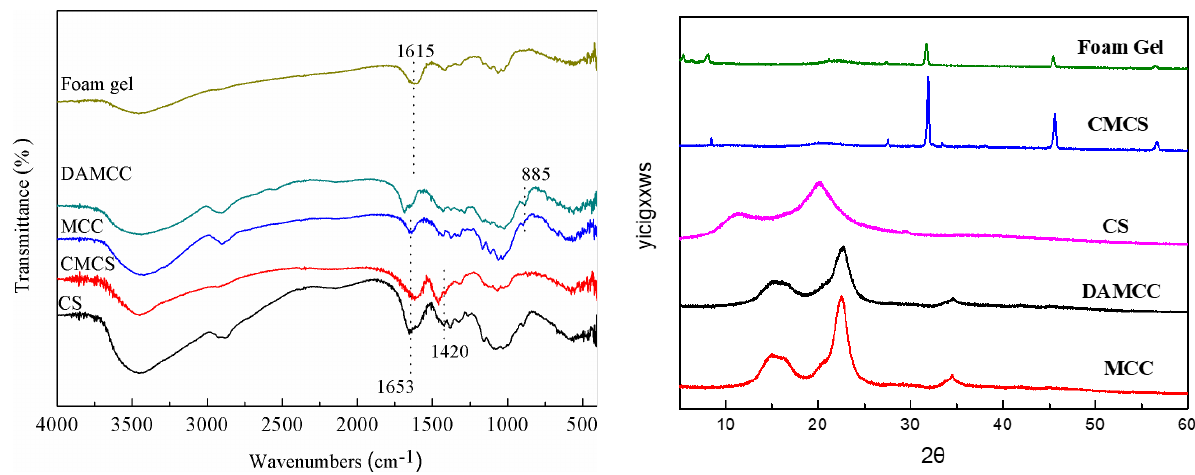
Figure 9: XRD images of CS, CMCS, MCC, DAMCC and